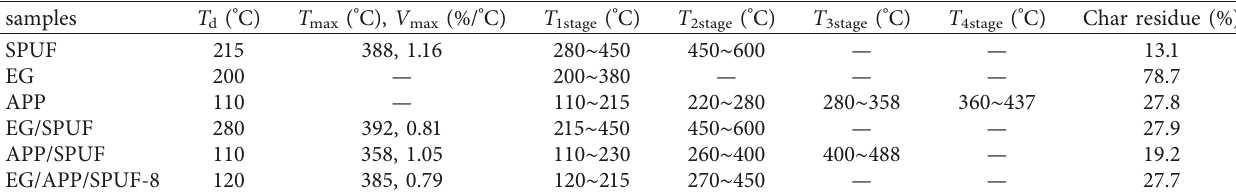
Figure 1: TG and DTG curves of EG, APP, SPUF, and SPUF composites. Table 3: Thermal properties of flame retardants and SPUF composites.